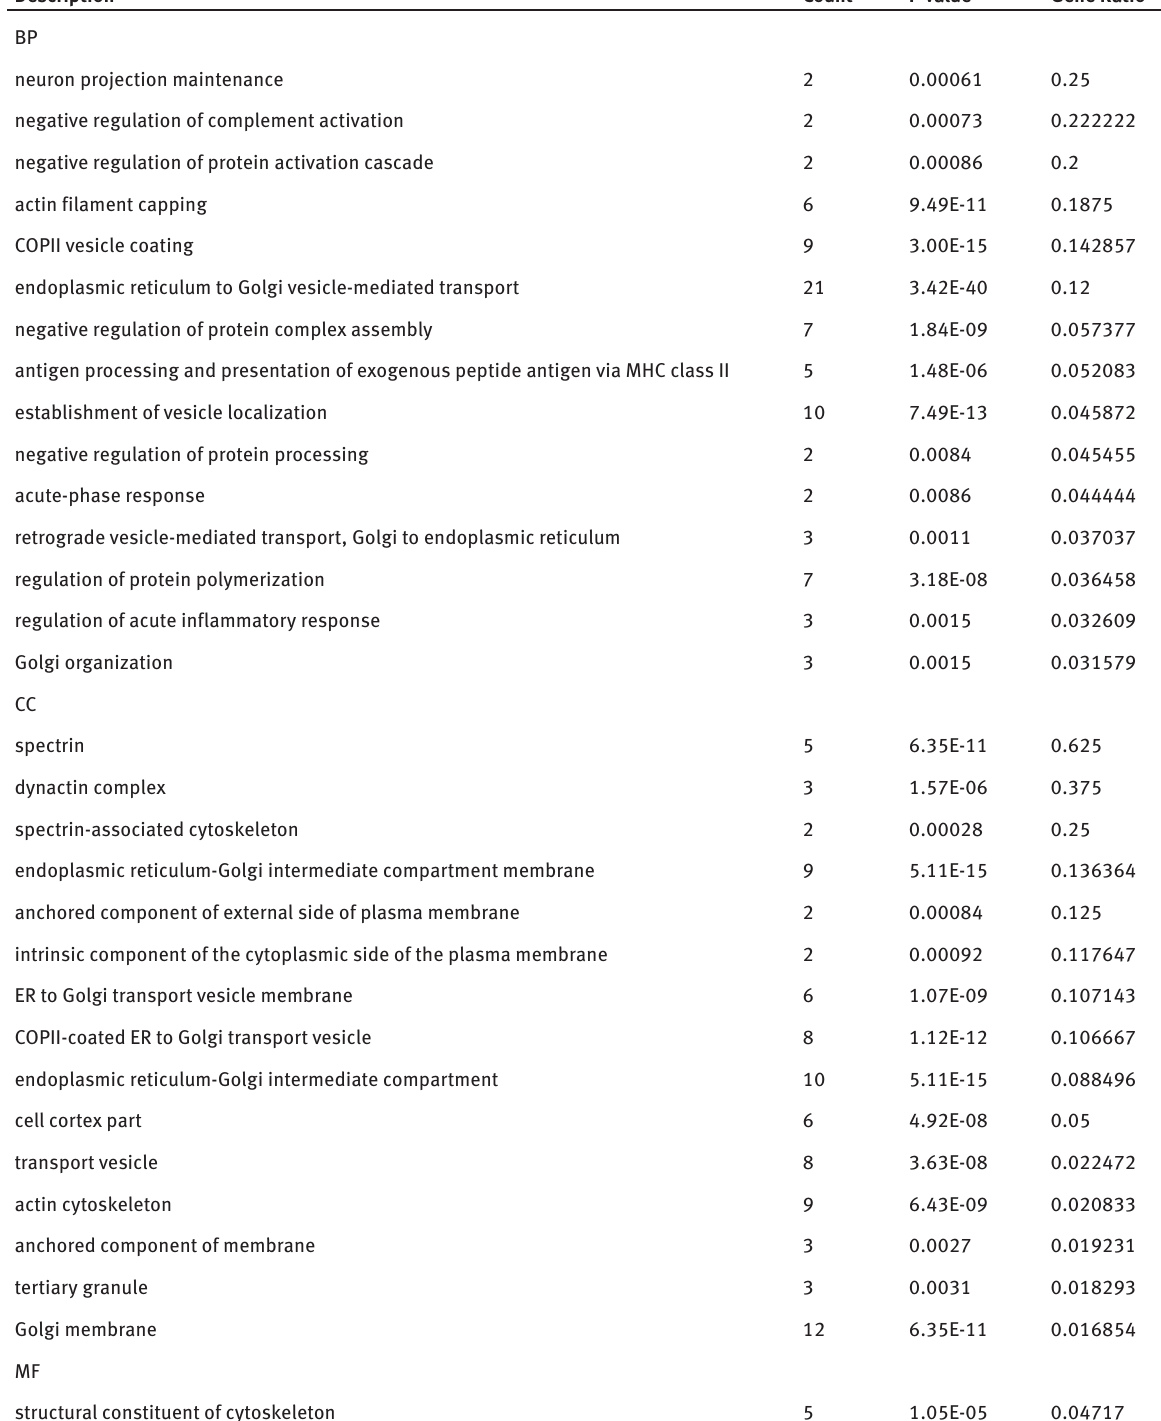
Table 2: GO enrichment of FOLR1 and relevant genes in the aspects of BP, CC and MF.